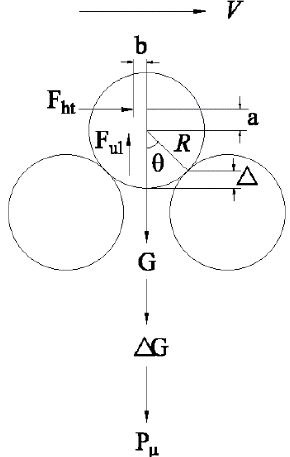
Figure 2. Critical condition within the equilibrium of moment for the particle initiation.